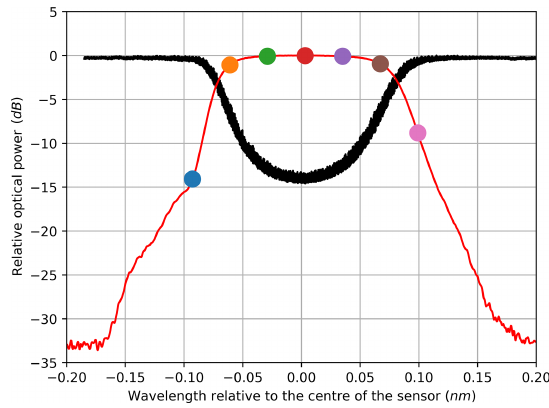
Figure 6. Electrically derived filter characteristic of an FBG in re- flection configuration (red) vs. optically derived filter characteristic of an FBG in transmission configuration (black).